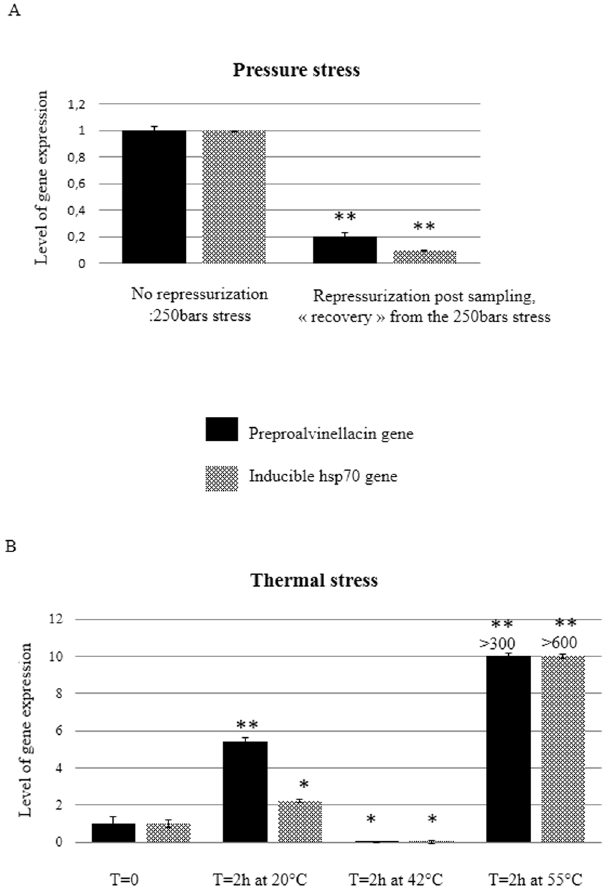
Figure 5. Upregulation of expression of the preproalvinellacin gene and the molecular chaperone hsp 70 in Alvinella pompejana submitted to thermal or pressure stress. ( A ) The level of transcription is significantly higher for both genes in “not re-pressurized animals” compared to those re-pressurized immediately after raising from − 2500 m at the in situ pressure of 250 bars in the DESEARES vessel. ( B ) In animals kept under in situ pressure in the BALIST device, thermal stress led to an up-regulation of the two genes. P-values from Student’s tests were calculated versus the control treatment (normalized to 1), based on the experimental measures performed in triplicates ( ** p < 0.01, * p <